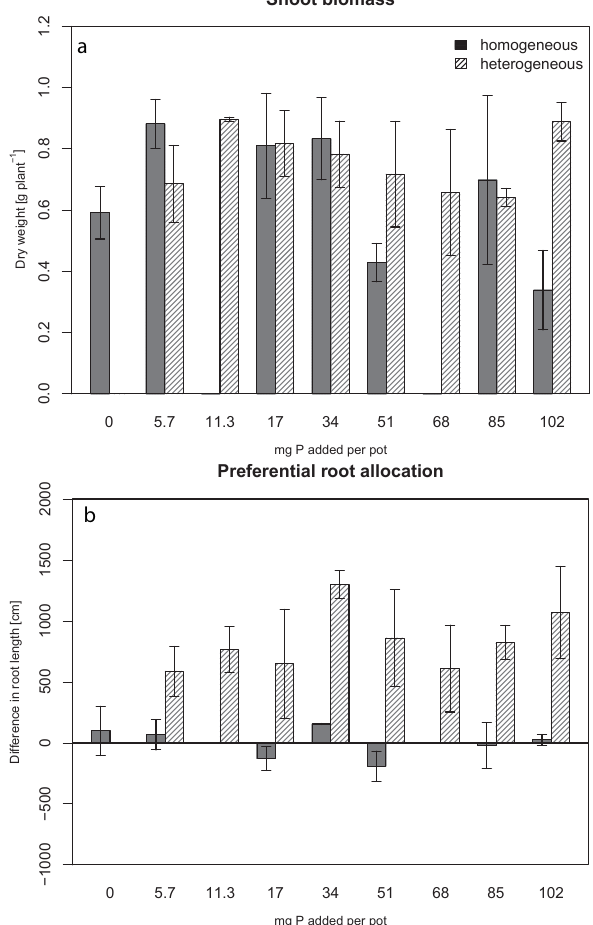
Fig. 2. (a) Shoot dry weight production of L. corniculatus grown in containers filled heterogeneously (stippled bars) or homogeneously (grey bars) with soil. (b) Preferential root allocation was calculated as the difference of root length in the right third of the container (P-fertilized in the heterogeneous treatments) and the left third of the container (unfertilized). Error bars refer to the standard error of the mean. Preferential root allocation was significant in all hetero- geneous